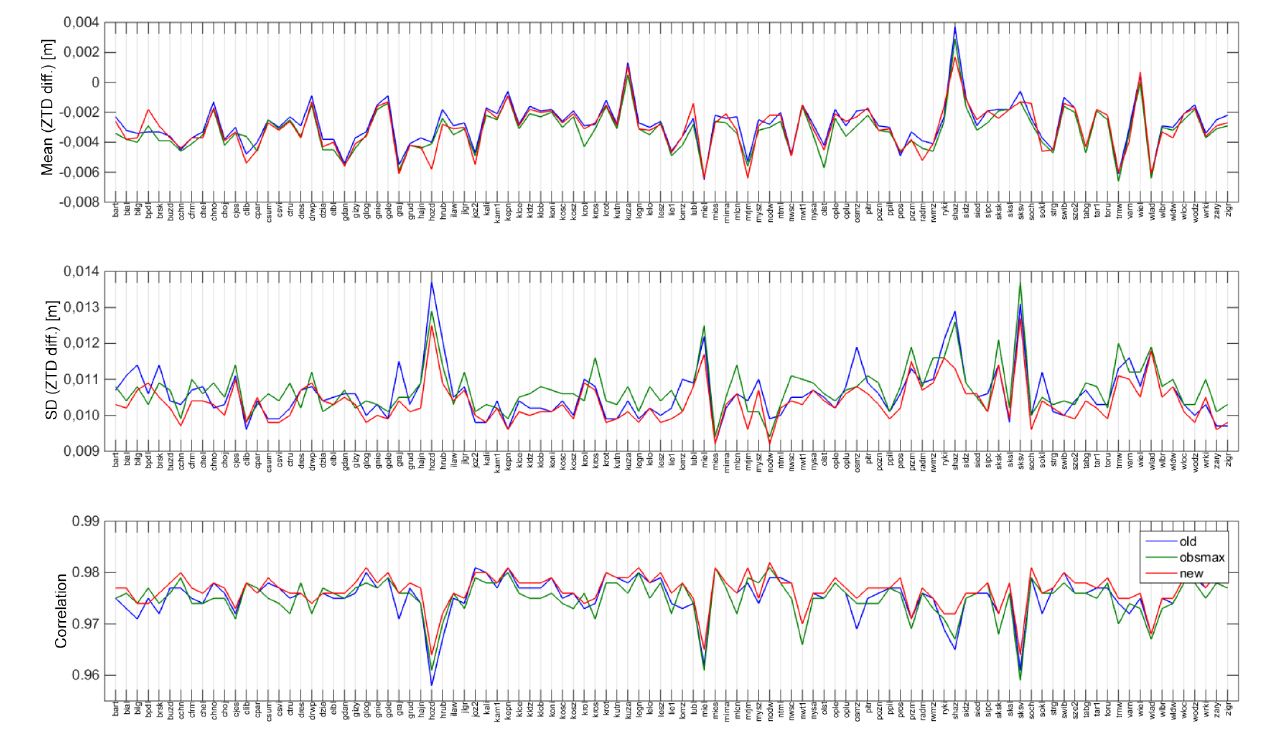
Figure 13. Distribution of mean differences, standard deviations of differences, and correlation coefficients of ZTD estimates from GPS and ERA-Interim at 103 common ASG-EUPOS stations. GPS data for the three different processing strategies, after screening variant no. 2, are